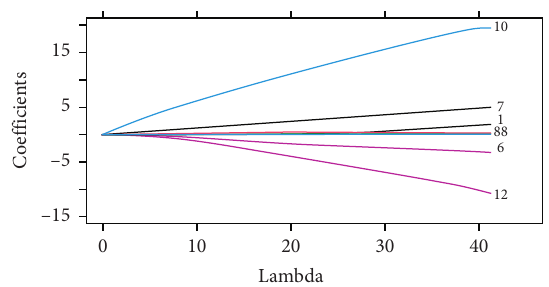
Figure 6: Ridge regression of trimmed variables.